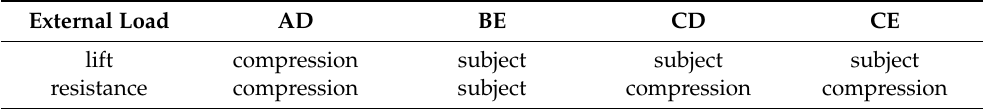
Table 1. The load direction of the driving